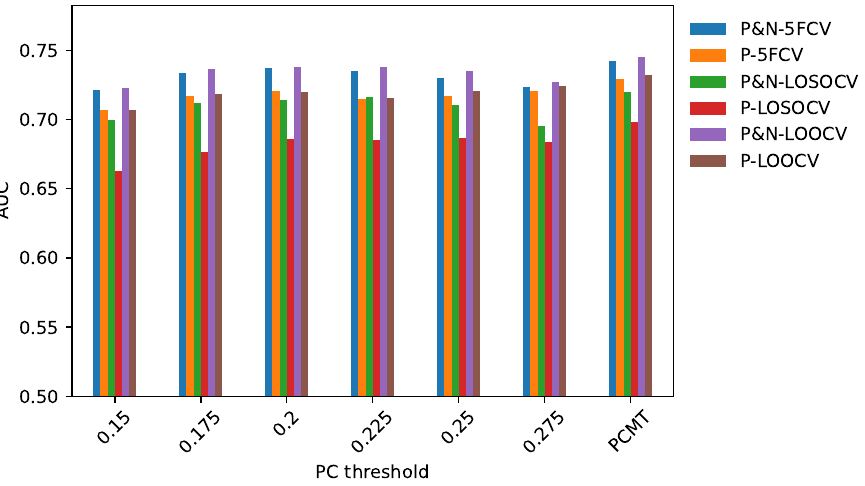
Figure 5. AUC comparison between personalized classifiers trained on positively and negatively correlated samples and personalized classifiers trained on only positively correlated